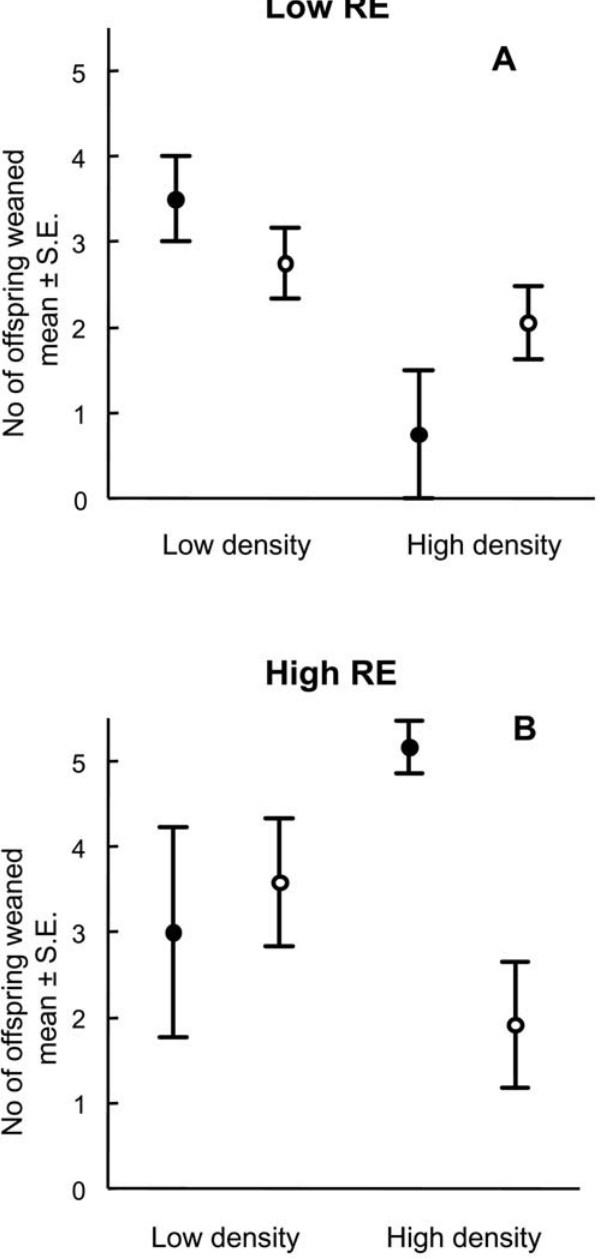
Figure 1. Number of offspring weaned of low (a) and high RE females (b) in different densities and frequencies. Closed circles: rare tactic; Open circles: common tactic in the populations.